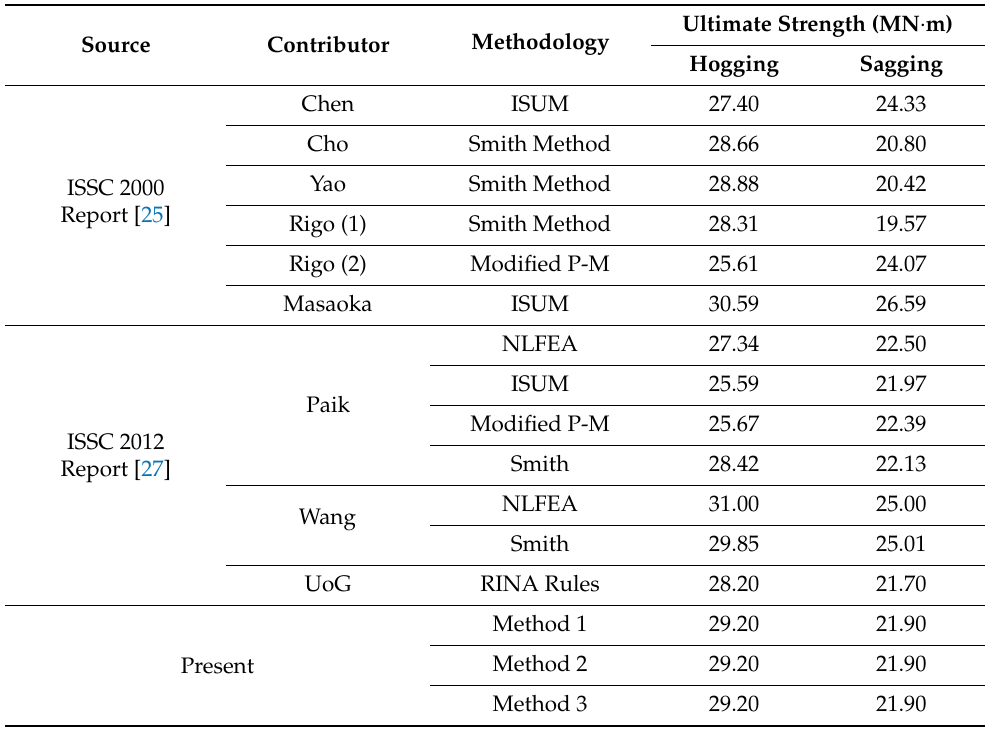
Figure 16. Rotation of neutral axis in CASE 3. Table 5. Comparison of ultimate strength obtained by different contributors.